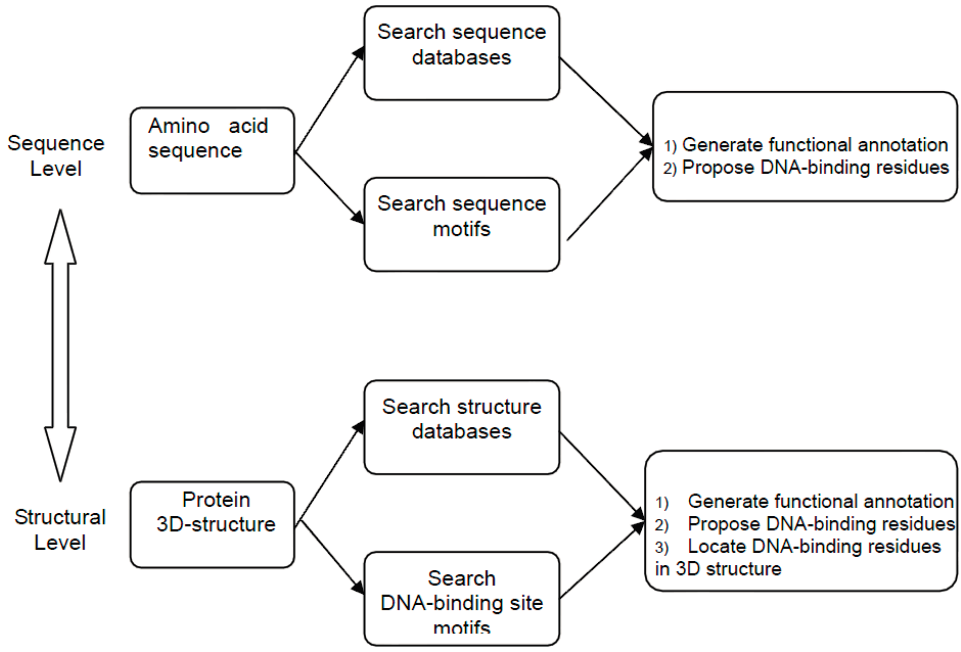
Figure 1. Sequence similarity and structure similarity-based